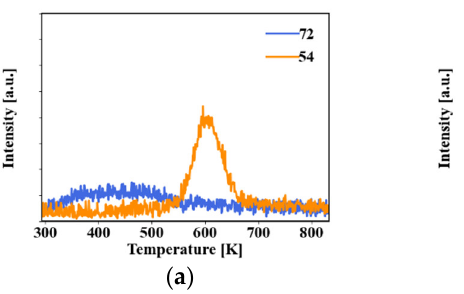
( c ) Figure 4. TPD data for the reaction of isopropanol on ( a ) Na-free ZrO 2 ( b ) 1 wt% Na-ZrO 2 ( c ) 2 wt% Na-ZrO 2 : isopropanol-m/e 45; propene-m/e 41 at high temperature; acetone-m/e 43 at high temper- ature. Both the steady-state reactivity and TPD data for the cyclic ethers and alcohols show that adsorbed Na is highly effective at poisoning the sites involved in the ring opening of THF and THP but has a lesser effect on the dehydration of the adsorbed alcohols (or alkox- ides) that are likely intermediates in the dehydra-decyclization reactions. These results again suggest that there may be different types of sites or site pairs on the ZrO 2 surface on which ring opening of cyclic ethers and dehydration of alcohols proceed. To further in- vestigate this possibility, we studied the reaction of both alcohols and cyclic ethers on several different types of zirconia, including single-crystal surfaces and ZrO 2 -thin films that were grown by ALD on both MAO and silica supports. In the single crystal studies, we used TPD to characterize the reaction of THF on the (100) and (110) planes of the yttria-stabilized, cubic ZrO 2 (YSZ). These samples were doped with yttria to stabilize the cubic phase, thereby avoiding the phase transitions, which occur upon heating ZrO 2 [24]. Prior studies have shown that YSZ and ZrO 2 surfaces